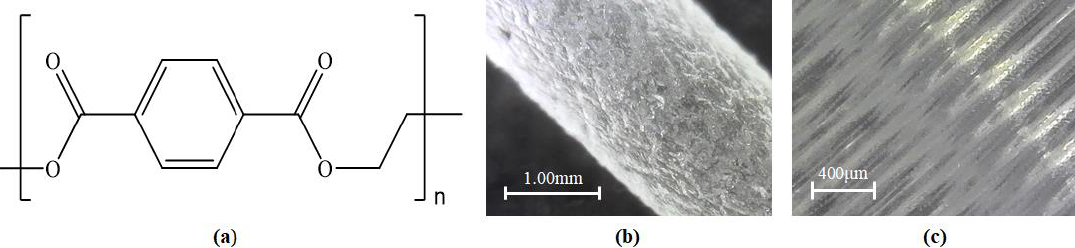
Figure 9. PET ( a ) chemical structure; ( b ) raw material; and ( c ) final processed material.